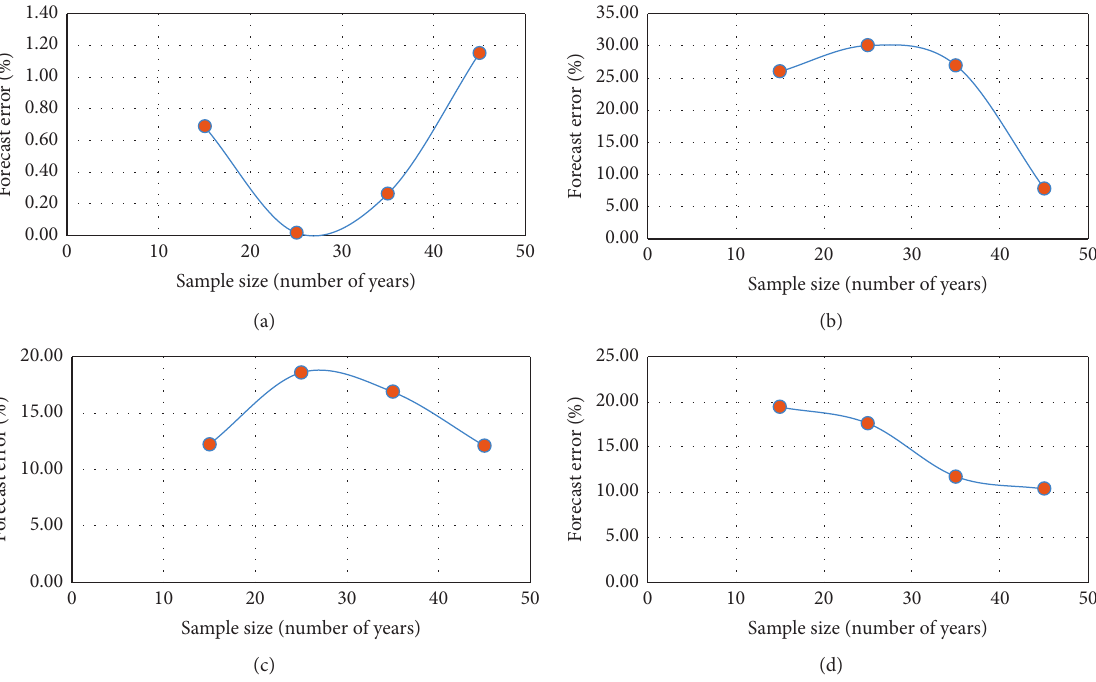
Figure 3: Forecast error for the subject countries, 2017. (a) Forecast error for Germany, 2017. (b) Forecast error for Denmark, 2017. (c) Forecast error for Israel, 2017. (d) Forecast error for Turkey,